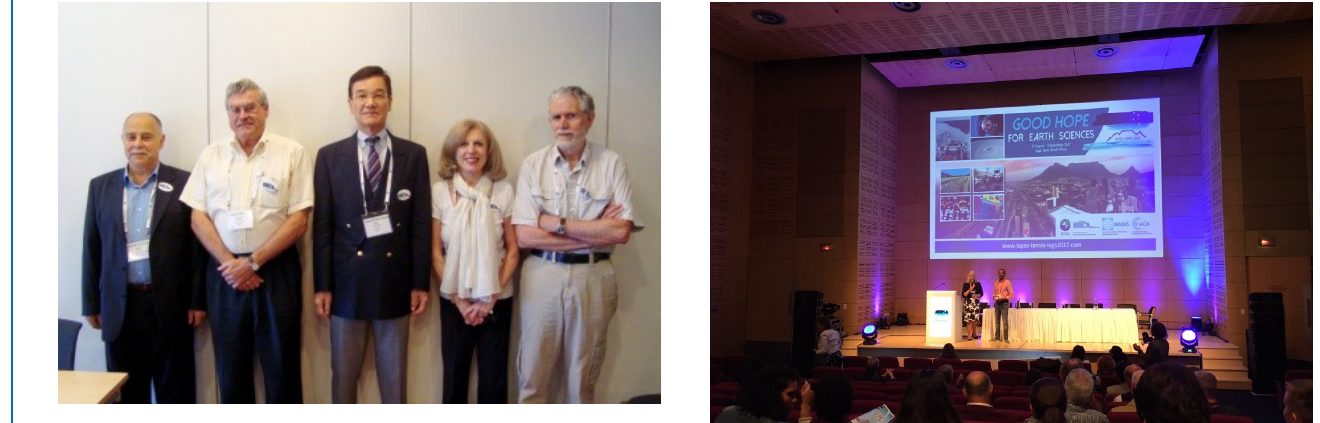
Figure 6. Five recent presidents of IAPSO: Eugene Morozov, Lawrence Mysak, Shiro Imawaki, Paola Malanotte-Rizzoli, and Robin Muench (source: IAPSO archives). Figure 7. Presentation of the 2017 La Fond Medal to Johnathan Durgadoo (source: IAPSO